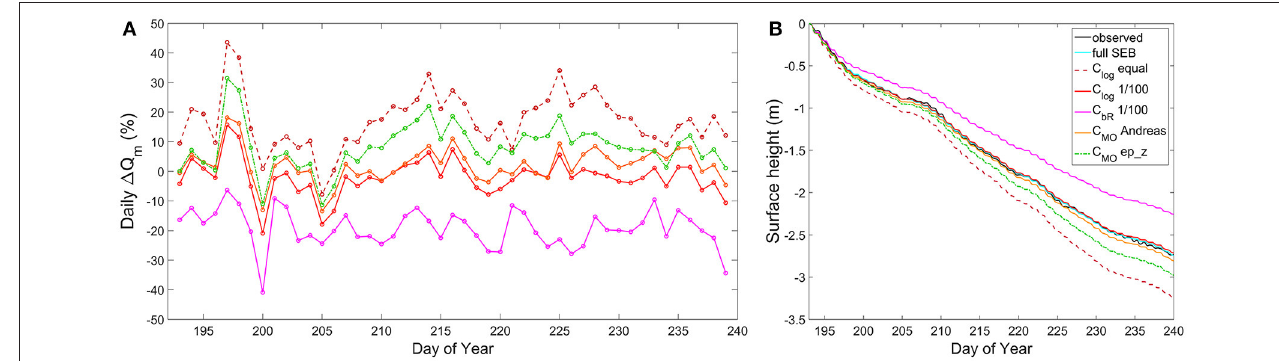
FIGURE 11 | (A) Deviation from daily Q M for a range of simplified SEB models with varying turbulence parameterizations (stability and roughness scheme identified), and (B) the cumulative effect of these deviations on modeled surface height over the study period. Each of the simplified models also assumes negligible Q R and Q G , and constant T s and L o